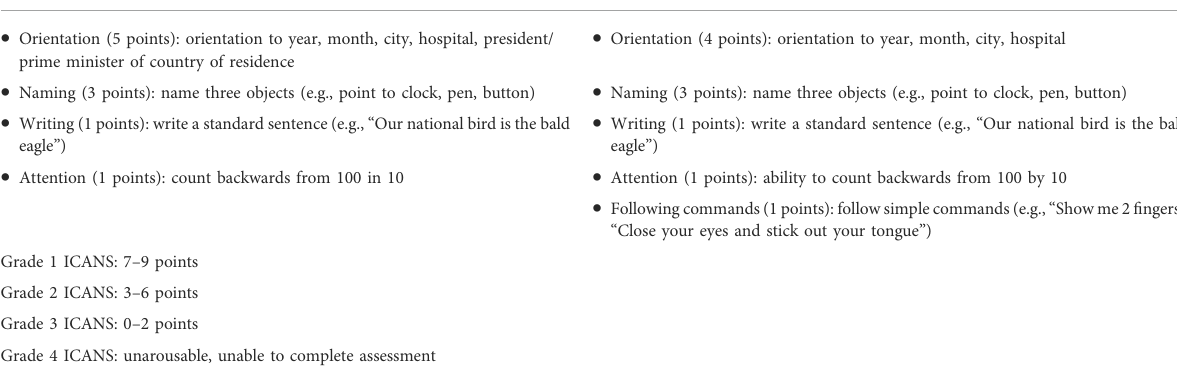
TABLE 8 Encephalopathy assessment tools for grading of ICANS. CARTOX-10 (Neelapu et al., 2018a) ICE (Lee et al.,